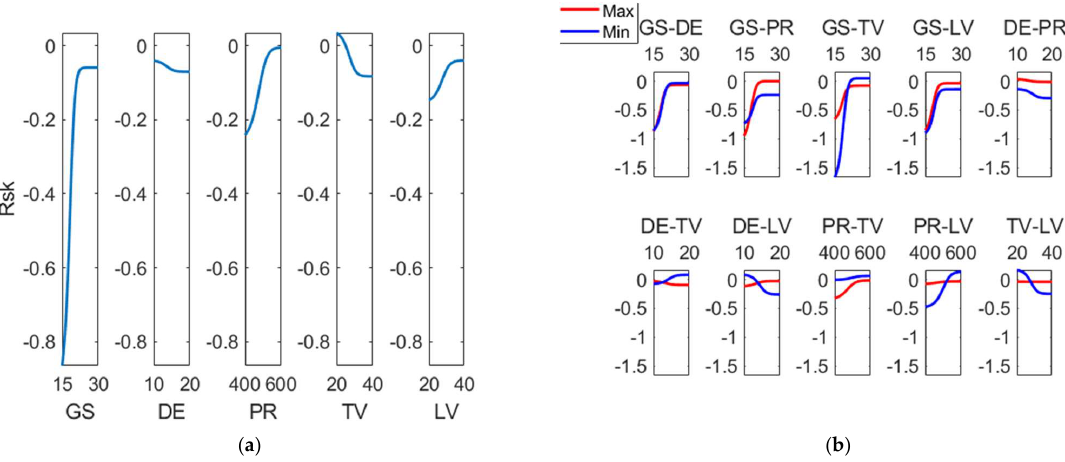
Figure 15. ( a ) Main effects plot and ( b ) interaction effects plot for (Rsk). Figure 16 shows the main effects plot and the main interactions plot for skewness kurtosis (Rku). Main effect for (Rku) is grain size, followed by pressure. Most significant interactions correspond to (GS) with all the other variables. As a general trend, in grinding processes kurtosis is more related to grain size than to the cutting conditions [41]. In this work, (Rku) decreases with grain size. Conversely, in grinding processes of Inconel, (Rku) increases with grain size [39]. In polishing operations of copper parts, the corresponding areal kurtosis parameter (Sku) decreases slightly with grain size up to a certain grain size value and then increases [40].